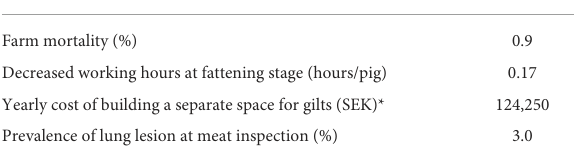
TABLE 3 Additional variables from the baseline farm model used in the partial budget model for strategy S2 (keeping purchased gilts separated from existing